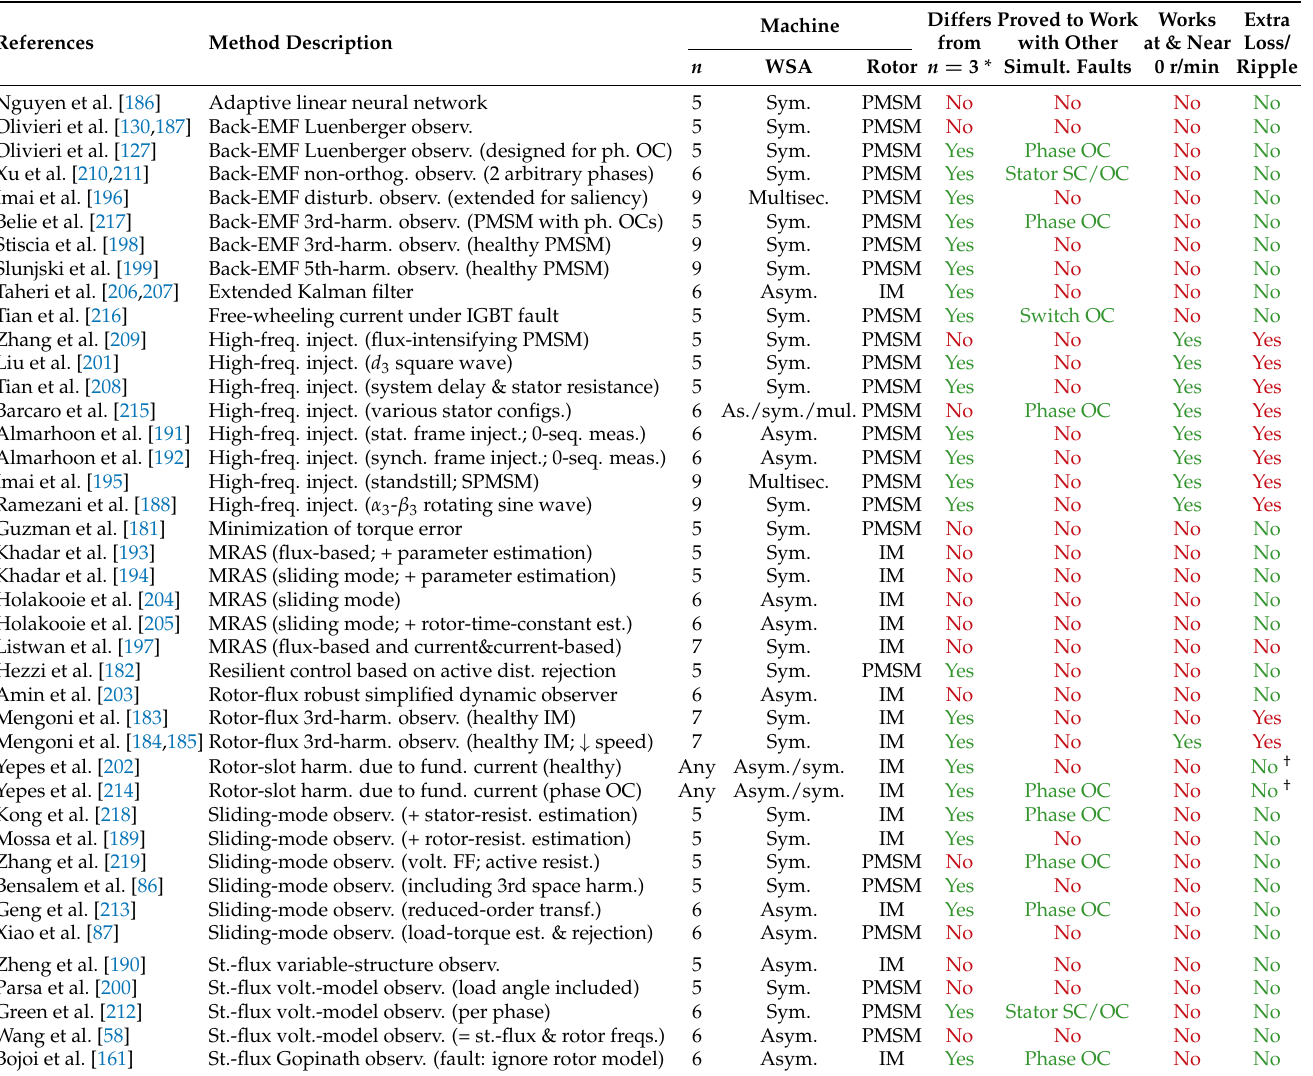
Table 17. Speed/position-sensorless methods (Section 7) in multiphase applications in the literature.